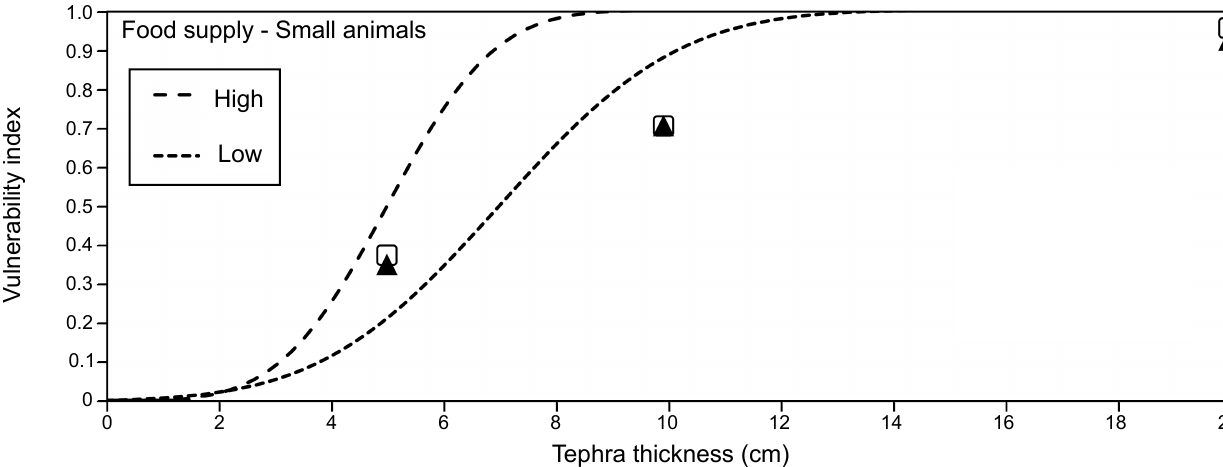
Figure 3: ‘High’ and ‘low’ vulnerability curves illustrating the likely e ff ects of tephra falls of between 0.1 and 20 cm (compacted thickness) on small animals. These curves are general vulnerability curves for small animals; ‘high’ and ‘low’ views may di ff er for specific animals or where the tephra fall has particular characteristics. See further explanation in the text. The squares represent the views of Participant A, the triangles the views of Participant